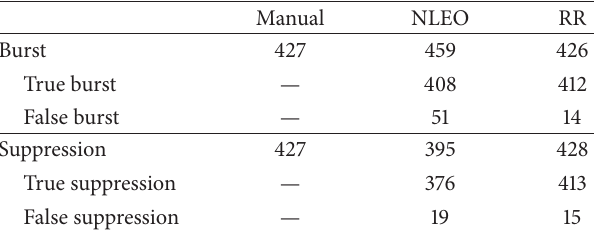
Table 2: The classification of manual, NLEO, and RR